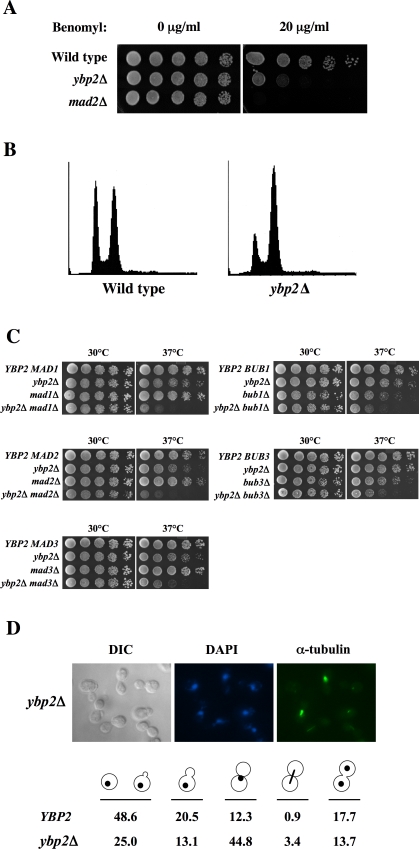
Ybp2 has a mitotic function.(A) The ybp2Δ mutant is sensitive to benomyl. Wild-type (BY4741), ybp2Δ (Y1028), and mad2Δ (Y516) strains were spotted in 5-fold dilutions from 5×104 cells per spot on YPD plates containing 20 µg/mL benomyl and incubated at 25°C for 3 days. (B) The ybp2Δ cells accumulate at G2/M. Logarithmically growing cells, wild type (Y14) and ybp2Δ (Y1831), were cultured at 25°C and processed for flow cytometry. (C) Double mutants of ybp2Δ and the spindle checkpoint genes show temperature-dependent synthetic lethality. Yeast strains were spotted in 5-fold dilutions from 5×104 cells per spot on YPD plates. The plates were incubated at the indicated temperatures for 2 days. Isogenic yeast strains were wild type (YPH500), ybp2Δ (Y1342), mad1Δ (Y550), mad2Δ (Y1323), mad3Δ (Y554), bub1Δ (Y530), bub3Δ (Y548), ybp2Δmad1Δ (Y1398), ybp2Δmad2Δ (Y1419), ybp2Δmad3Δ (Y1402), ybp2Δbub1Δ (Y1415), and ybp2Δbub3Δ (Y1396). (D) Immunofluorescence analysis of ybp2Δ cells. Logarithmically growing cells cultured at 25°C were fixed and stained with antitubulin antibodies and DAPI. The strains shown are wild type (Y14) and ybp2Δ (Y1831). For each sample, 300 cells were counted.